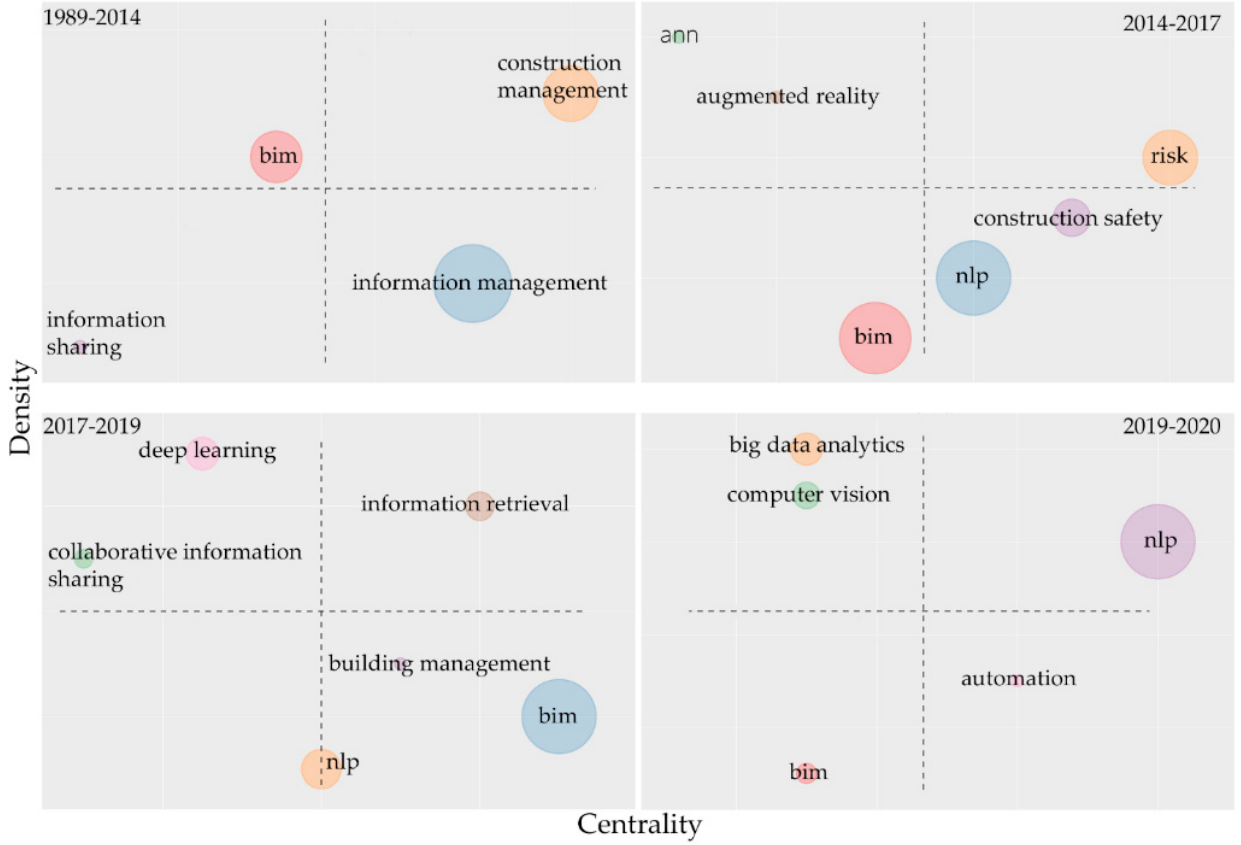
Figure 13. Thematic bivariate map. Software: BiblioShiny version 3.0.